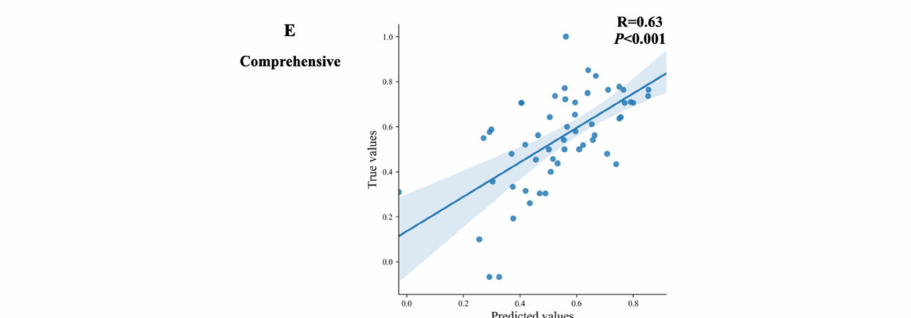
Figure 3. The correlations between true values and predicted values in the regressions of different features. ( A ) the correlations between true values and predicted values in the regressions with gray matter volume values; ( B ) the correlations between true values and predicted values in the regressions with thickness values; ( C ) the correlations between true values and predicted values in the regressions with gyrification values; ( D ) the correlations between true values and predicted values in the regressions with sulcal depth values; ( E ) the correlations between true values and predicted values in the regressions with comprehensive values.